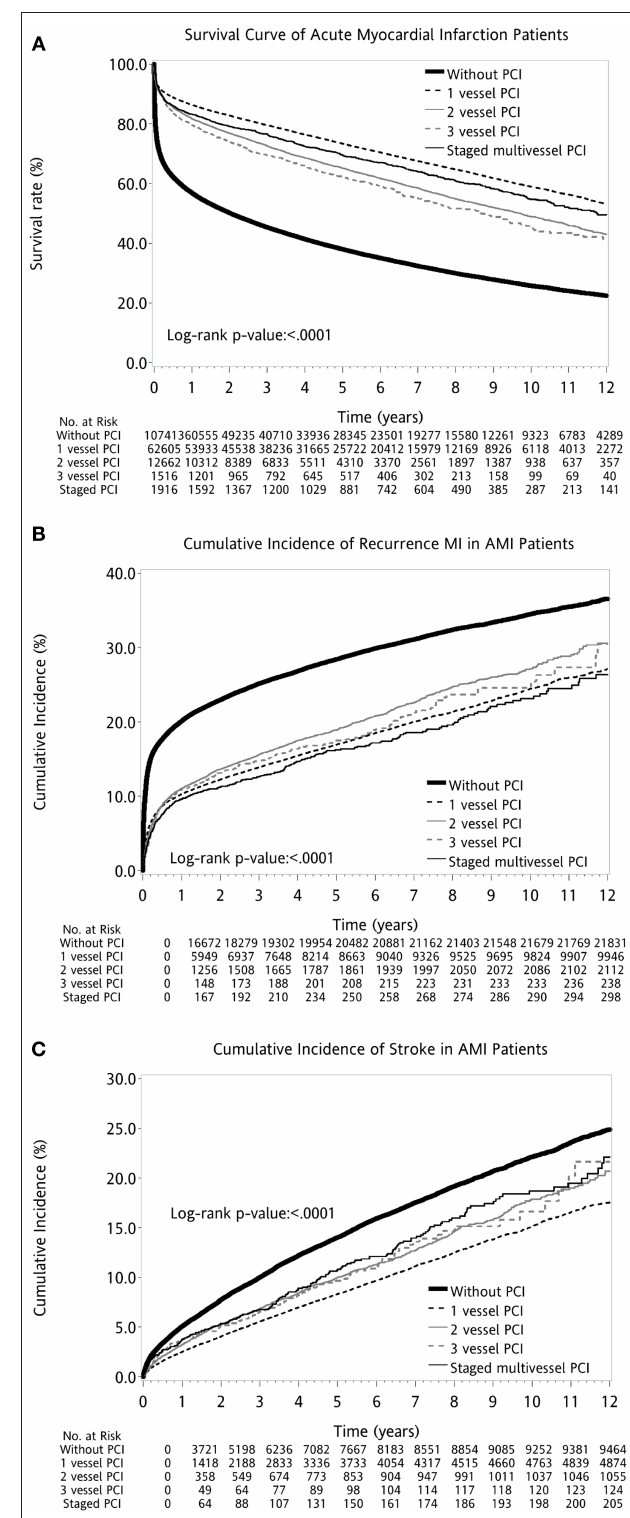
FIGURE 2 | Kaplan–Meier survival curves for different outcome measures after first AMI: (A) Survival. (B) Recurrent MI. (C) Stroke. AMI, acute myocardial infarction; PCI, percutaneous coronary